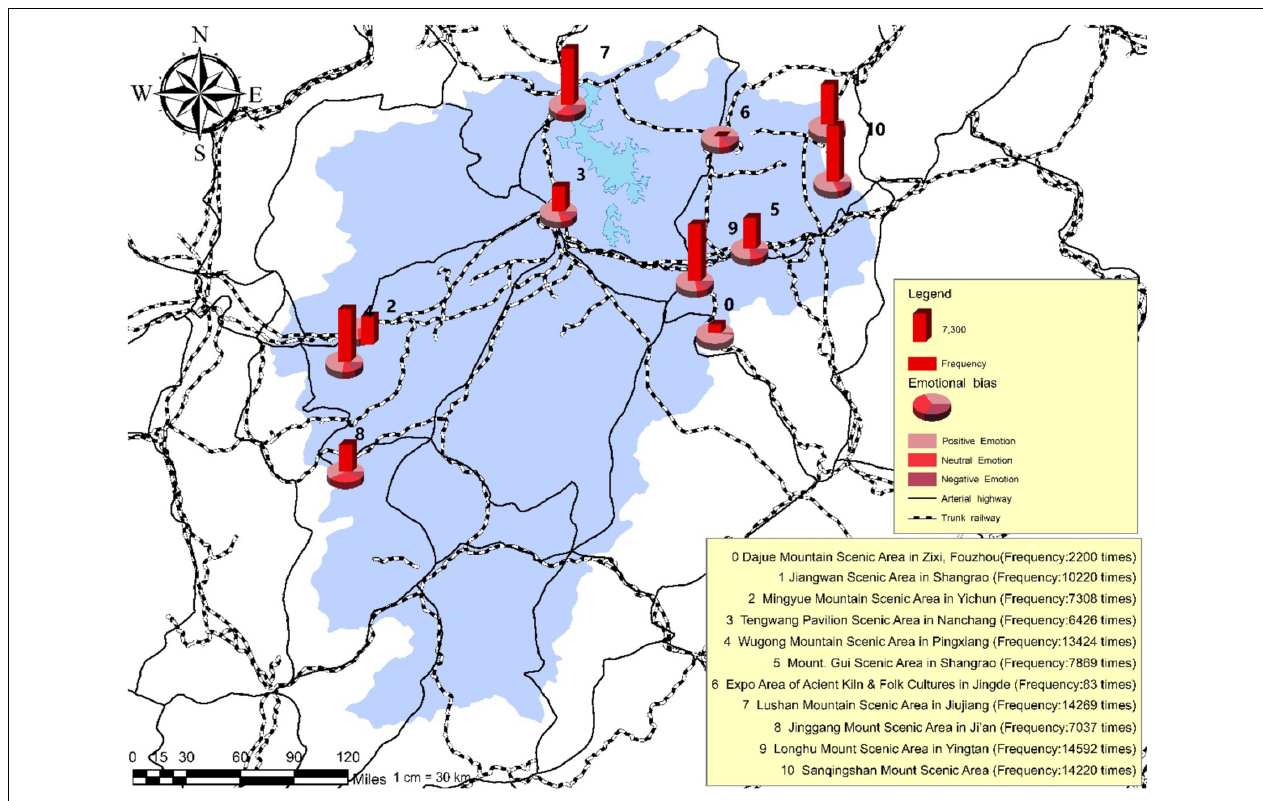
FIGURE 6 | The trunk railway points and line links of tourism destinations in the space and time